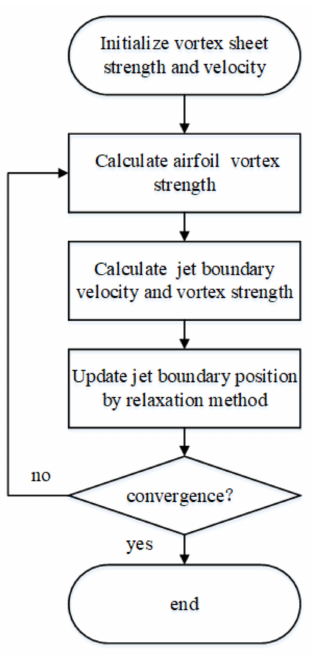
Figure 5. Numerical procedure of the developed